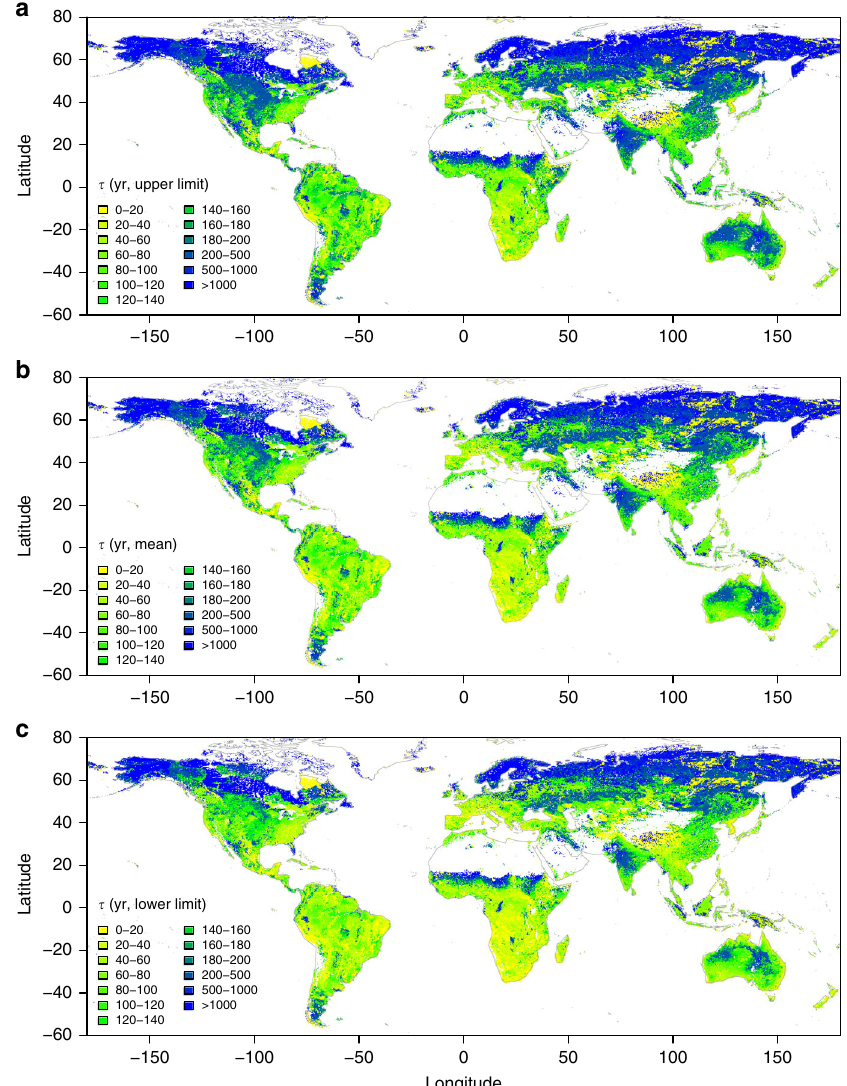
Fig. 1 Spatial pattern of subsoil organic carbon turnover times. a , b and c respectively show the upper limit (i.e., the 97.5% quantile), mean, and lower limit (i.e., the 2.5% quantile) of subsoil (0.3 – 1 m) organic carbon turnover times based on 200 bootstrapping simulations considering uncertainty in carbon input in each pixel at the resolution of